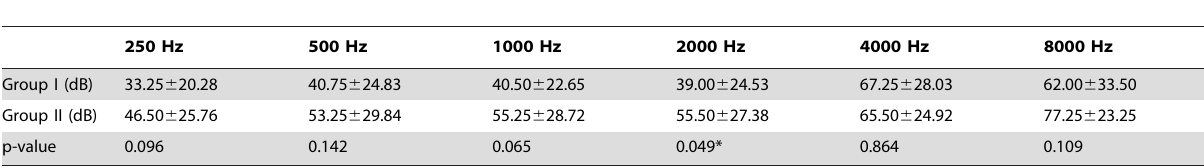
Table 2. Comparison of the posttreatment hearing levels at each frequency.